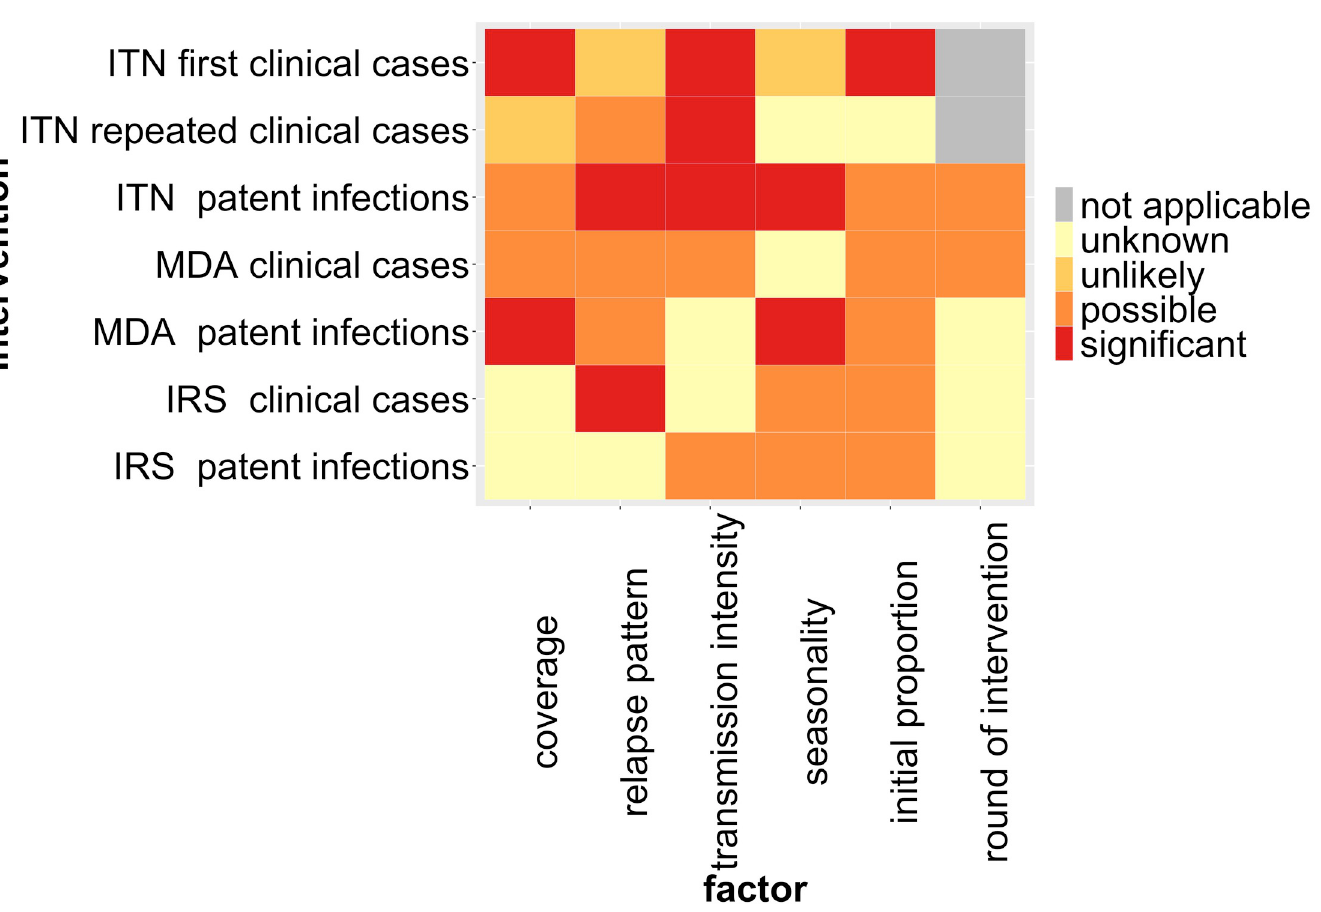
Fig 19. Heat map of factors by intervention. Factors were considered as ‘possible’ if the estimated change in odds over time was more than 1.01 per month or less than 0.99 per month in the logistic regression.